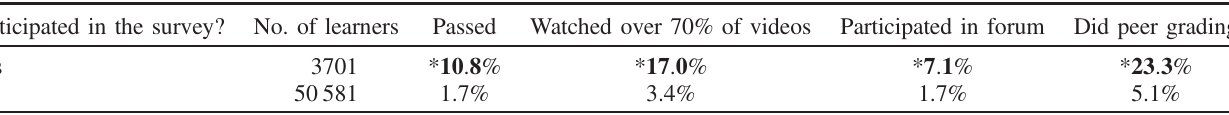
TABLE II. Comparison of engagement indicators between people who took the survey and who did not. Survey results in bold and denoted by an asterisk mark the statistically significant results of the Kolmogorov-Smirnov test at the p ¼ 0 . 05 level. Participated in the